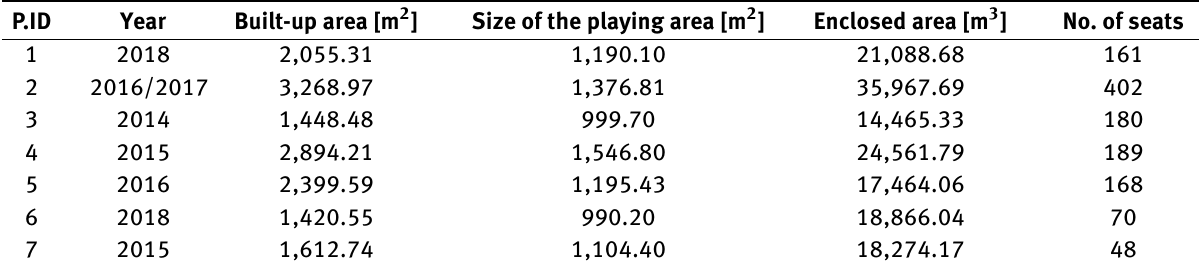
Table 1: Non-price input data [17].